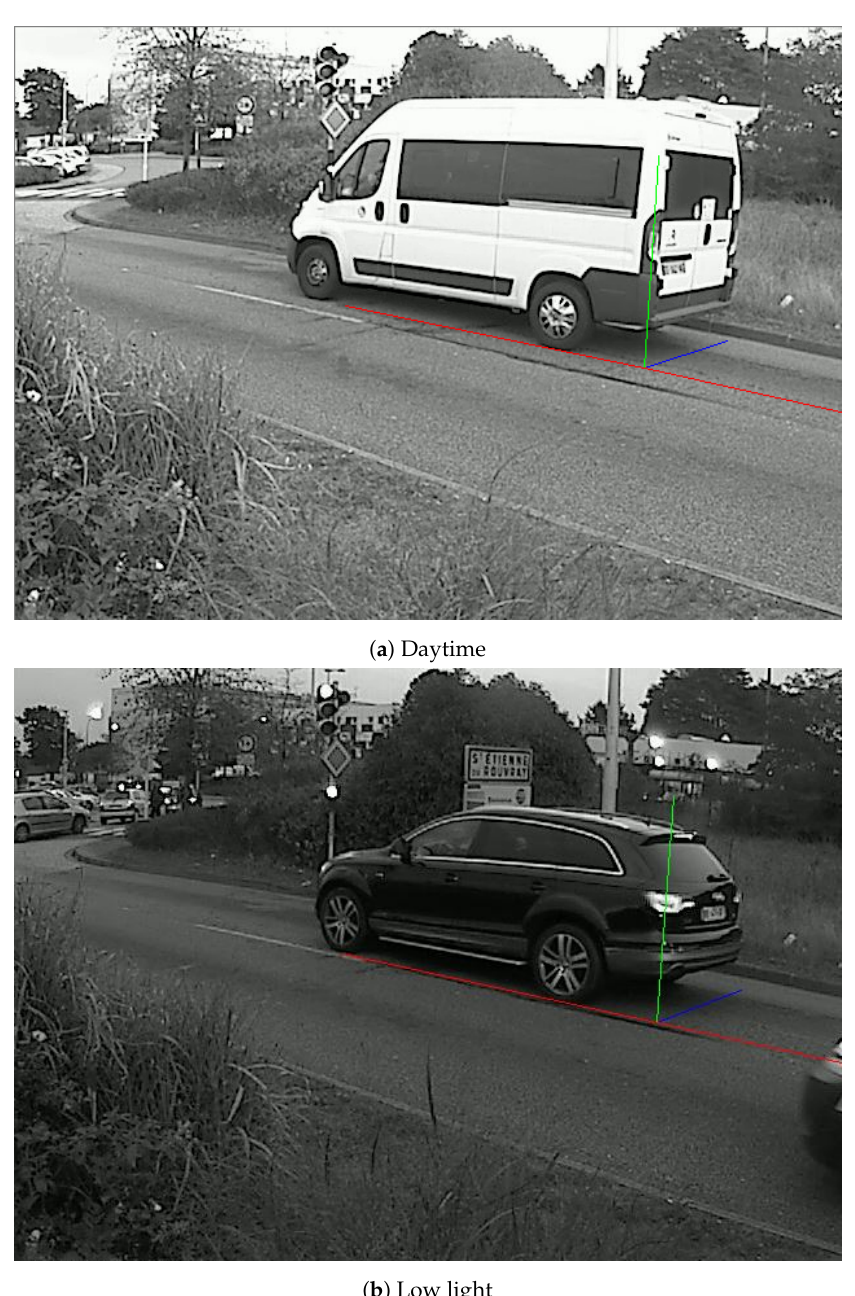
Figure 5. Samples from the dataset. Red line: projection of the longitudinal direction, Green line: projection of the vertical direction, Blue line: projection of the transversal